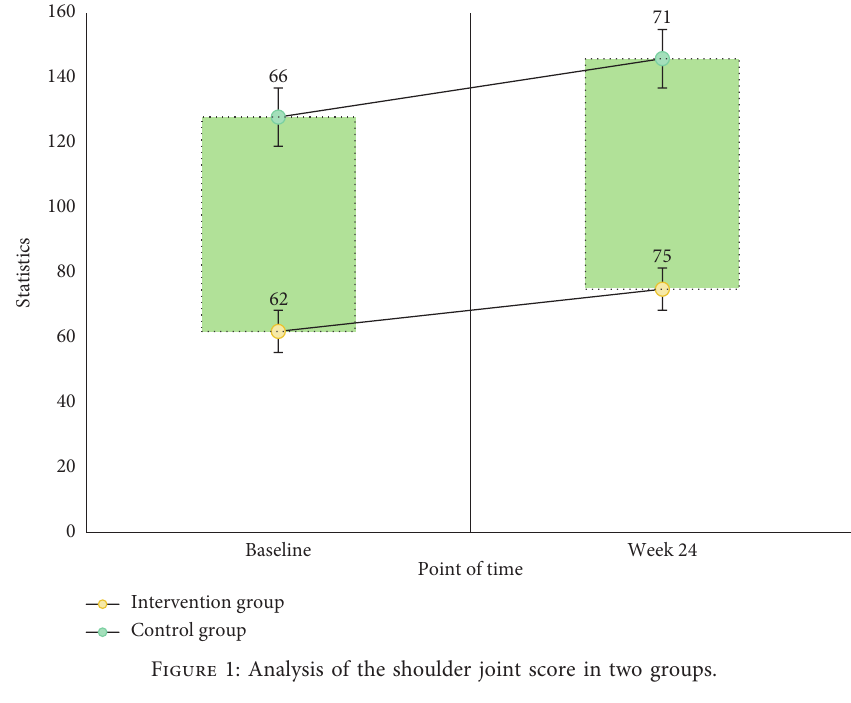
Figure 1: Analysis of the shoulder joint score in two